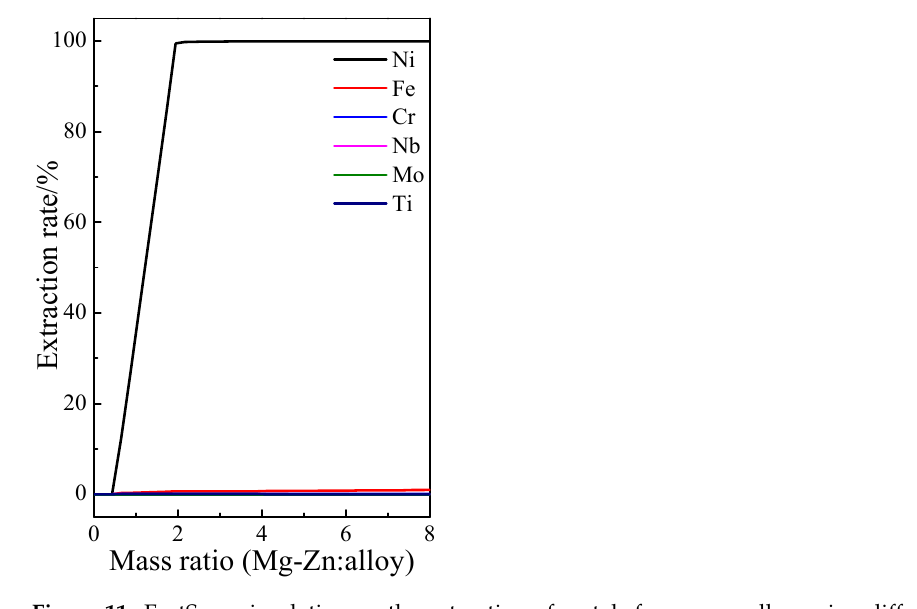
Figure 11. FactSage simulation on the extraction of metals from superalloy using different mass ratios of Mg-Zn to alloy at 800 °C and the molar ratio of Mg/Zn was 9/1 [32]. (In the calculation process, it was assumed that the mass of the initial superalloy was 100 g; liquid 1# in the Factsage calculation results was adopted. Note: the curves for Cr, Nb, Mo and Ti are overlapping).